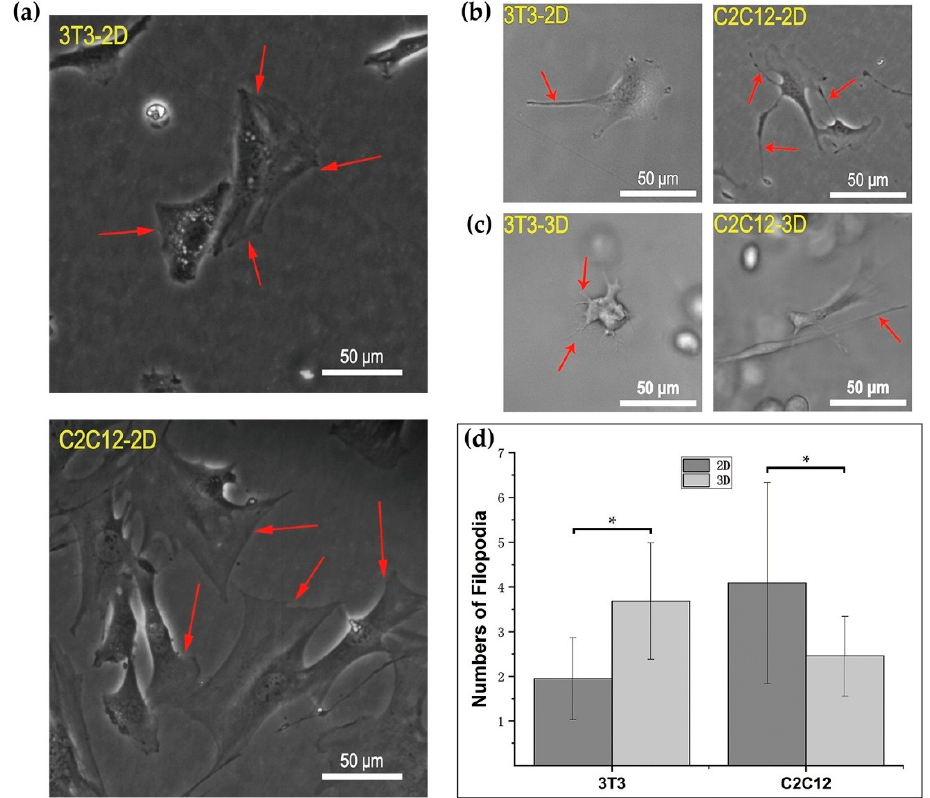
Figure 6. Lamellipodia and filopodia of cells in 2D dish and 3D dextran hydrogels. ( a ) Lamellipodia of 3T3 and C2C12 in 2D; ( b ) Filopodia of 3T3 and C2C12 in 2D; ( c ) Filopodia of 3T3 and C2C12 in 3D; ( d ) Numbers of filopodia of cells in 2D petri dishes and 3D dextran hydrogel. The data were presented by mean ± SD; * p < 0.05 versus the corresponding 2D control samples.